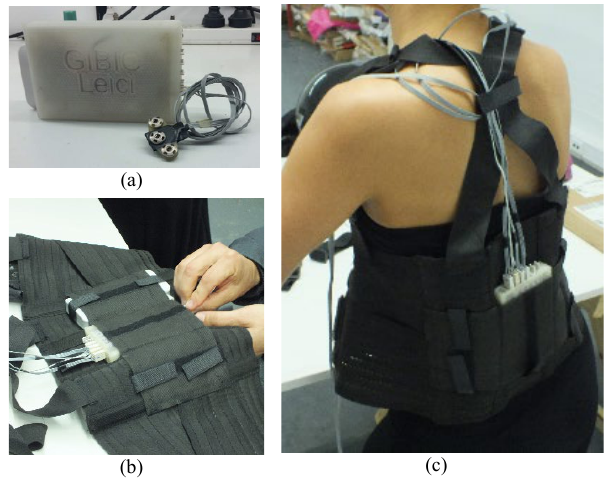
Figure 1. WIMUMO in a performance. (a) the wearable biopotential acquisition system, (b) WIMUMO and a battery pack placed in a textile elastic band and (c) installed on the performer body.